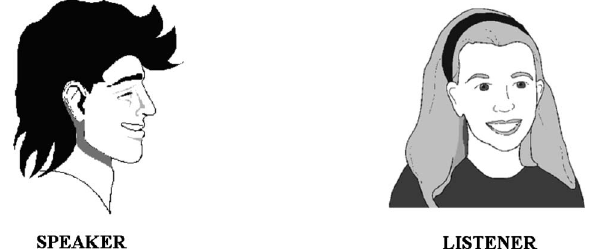
FIG. 5. Picture available to students for better understanding of the situation and for optional drawing during discussion related to context 2 in